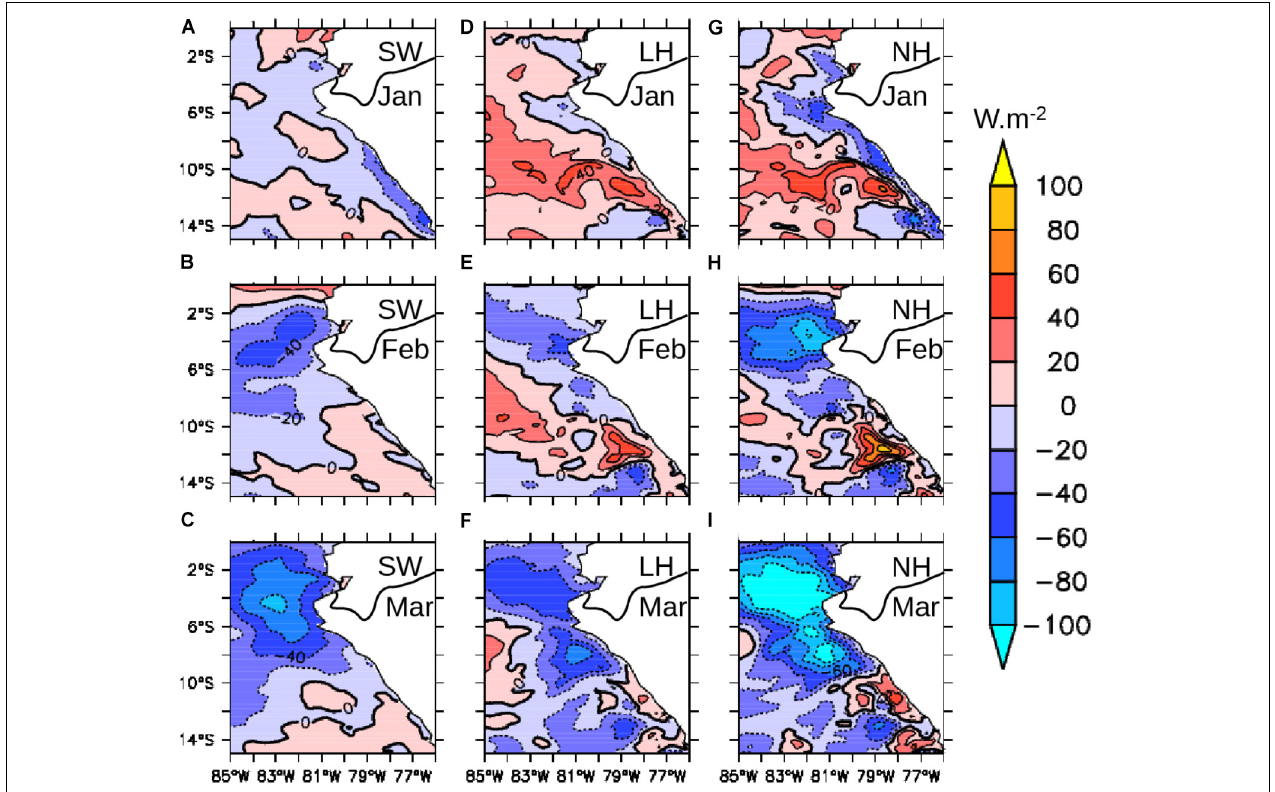
FIGURE 8 | Monthly heat flux anomalies (in W m − 2 , positive downward) in January, February, and March 2017: (A–C) short wave heat flux anomaly (SW); (D–F) latent heat flux anomaly (LH); and (G–I) net heat flux anomaly (NH). Positive fluxes indicate an input of heat into the ocean. Anomalies were computed with respect to the 2013–2016 model